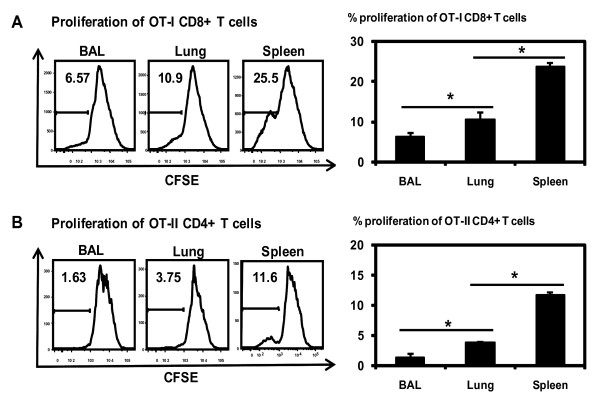
Antigen-specific transgenic T cell activation stimulated by virally transduced CD11c+ APCs from BAL, lung parenchyma and spleen. CD11c+ APC populations isolated from BAL, lung and spleen were infected with AdOVA and co-cultured either for 48 hours with CFSE-labelled OT-I CD8 T cells or for 72 hours with CFSE-labelled OT-II CD4 T cells. The rate of transgenic T cell proliferation was analyzed by FACS. A, OT-I CD8 T cell proliferation. B, OT-II CD4 T cell proliferation. Representative histograms of T cell proliferation are shown. The average T cell proliferation rates are shown in bar graphs after subtracting from appropriate controls. Results are presented as the mean ± SD of triplicate samples. *p < 0.05.